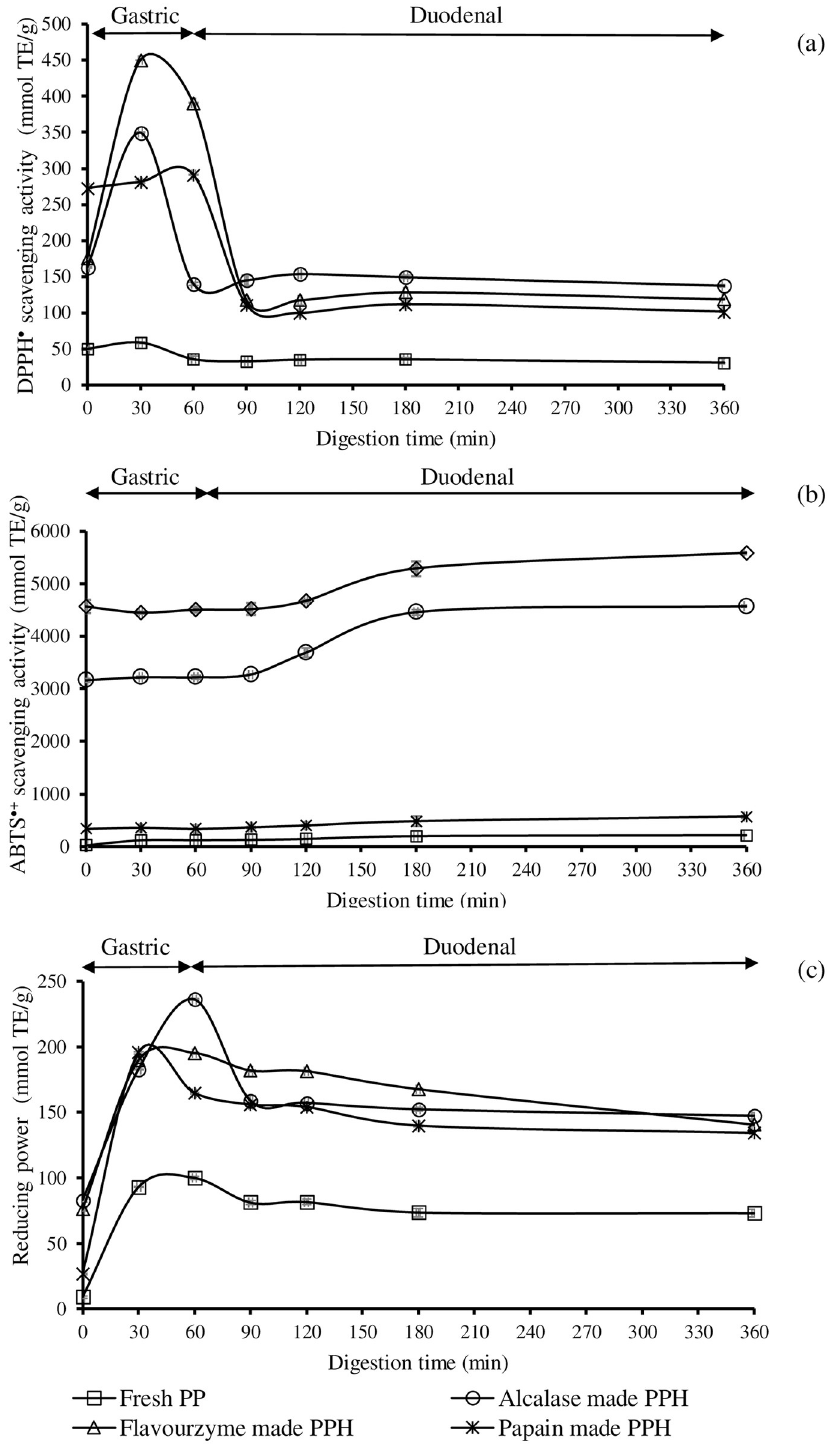
Fig 4. Changes in DPPH • scavenging activity (a), ABTS •+ scavenging activity (b), and reducing power (c) of porcine placenta hydrolysate (PPH), produced by Alcalase, Flavourzyme, and papain at 10% enzyme load for 20 min, in gastrointestinal (GI) tract model system. To compare, fresh porcine placenta (Fresh PP) was employed. Bars represent standard deviation from triplicate determinations. TE = trolox equivalent.